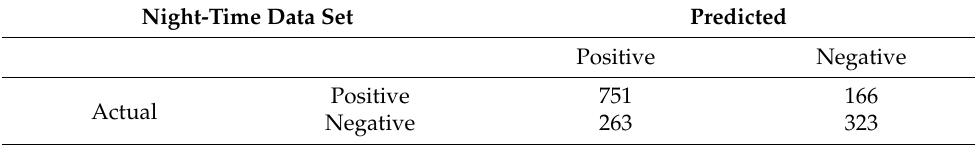
Table 6. Confusion matrix of night in SiamRPN.